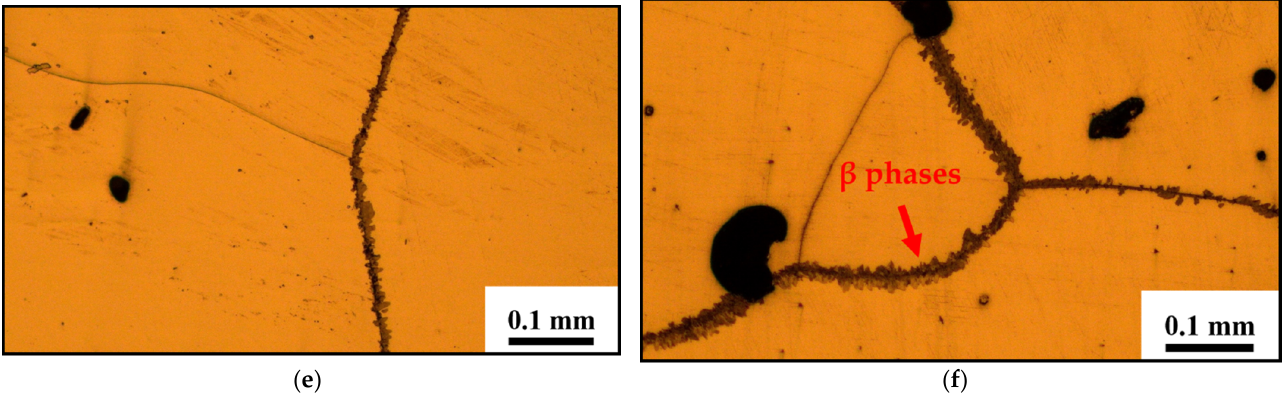
Figure 1. Optical microscope images of FeNiCoAlTiNb alloys in different aging conditions: ( a ) 600 °C—10 h, ( b ) 600 °C—12 h, ( c ) 600 °C—24 h ( d ) 600 °C—48 h, ( e ) 600 °C—72 h, and ( f ) 600 °C—96 h.